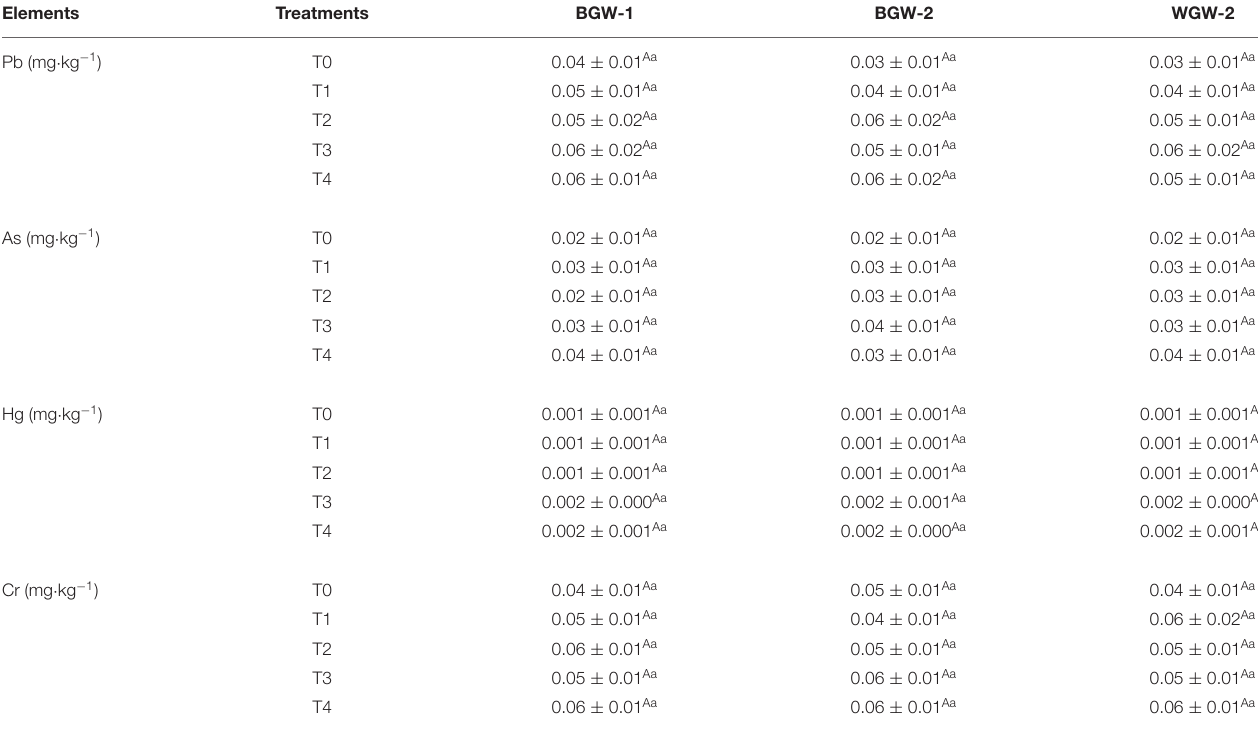
TABLE 4 | Effects of Se fertilization on Pb, As, Hg, and Cr concentrations in grains in the 2019–2020 season.